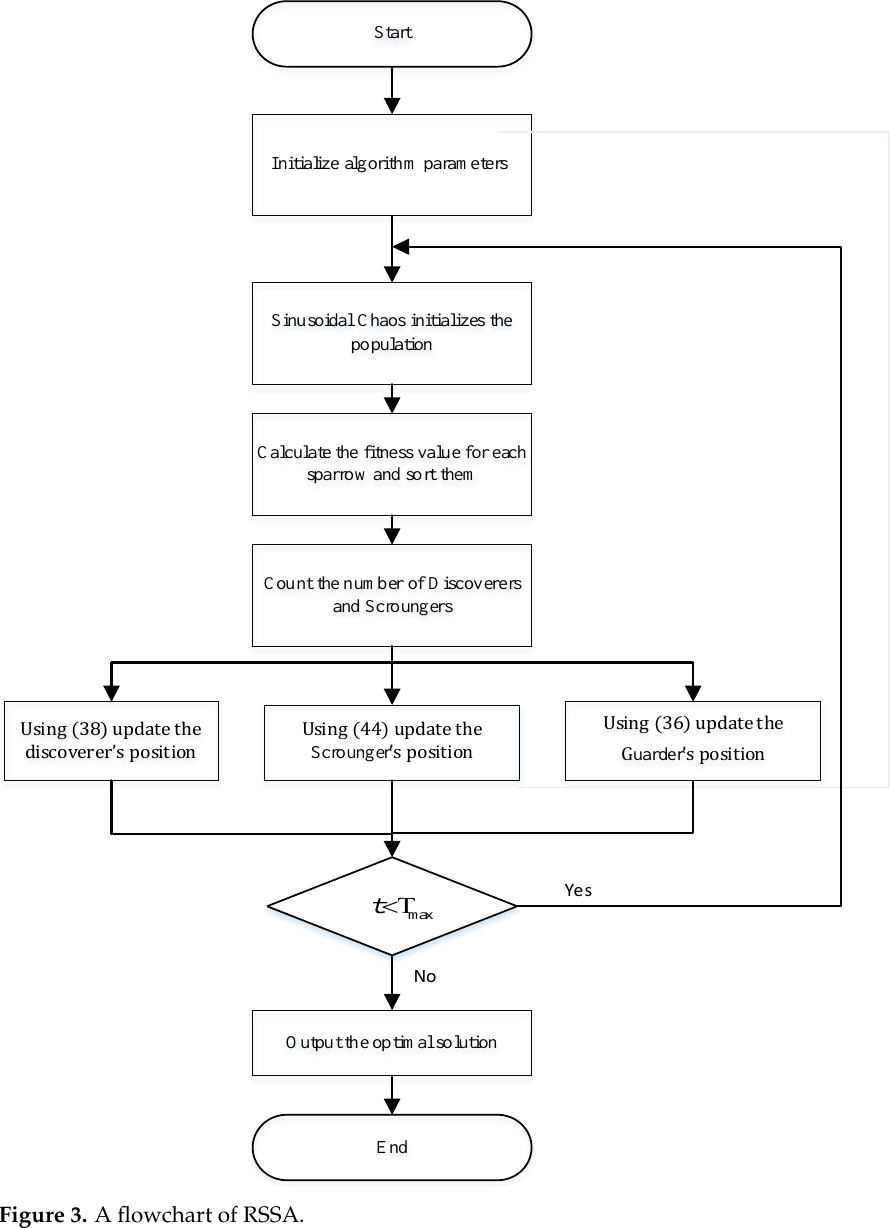
Figure 3. A flowchart of RSSA. Table 1. Algorithm parameter